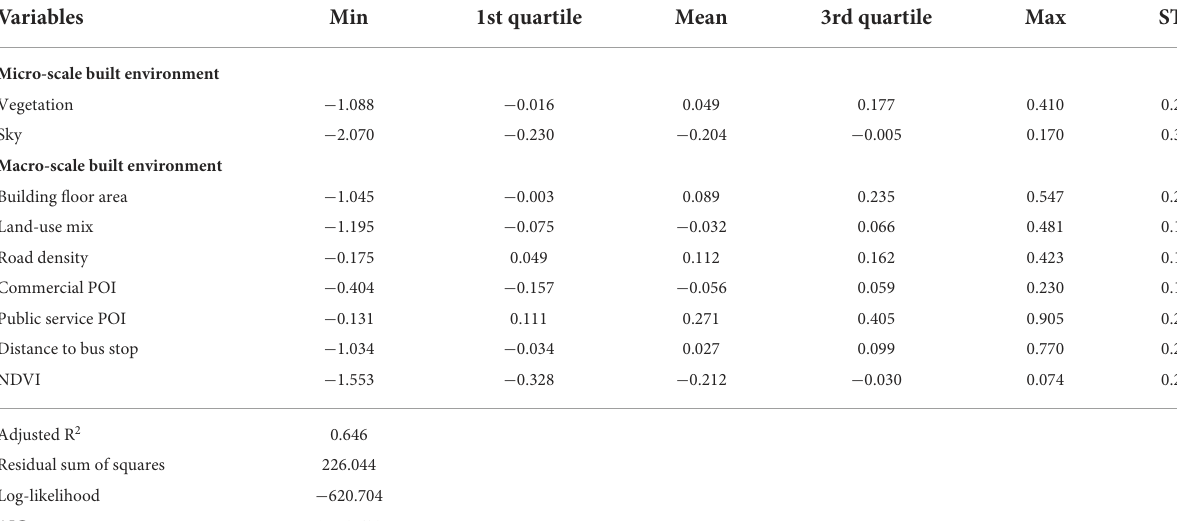
TABLE 4 Results of geographically weighted regression (GWR) model of built environment and e-bike (fishnet = 600 × 600m, N = 770). Variables